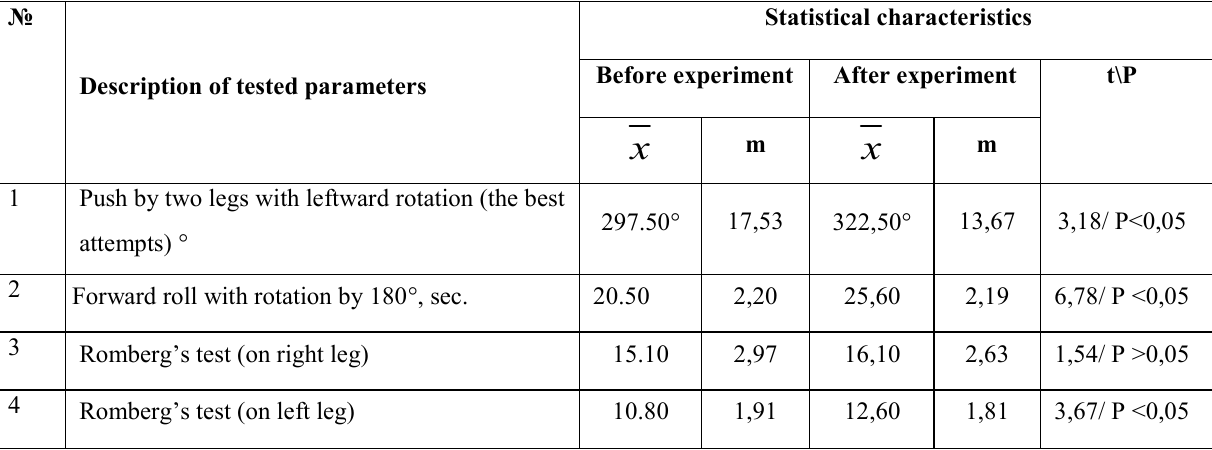
Results of control tests before and after